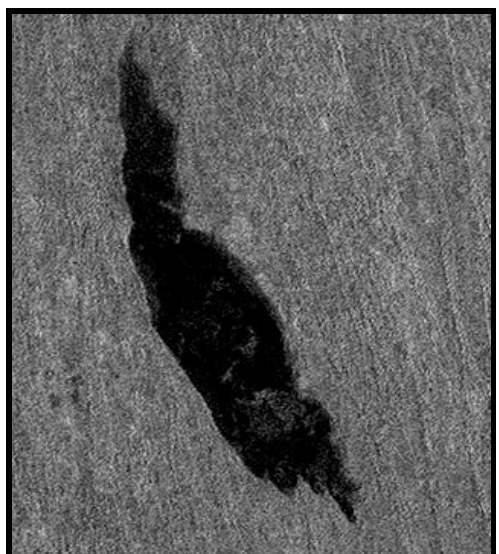
Figure 7. NCAS Landsat derived NDVI at a nominal 25 m spatial resolution showing the region around the salt lake in the centre of Figure